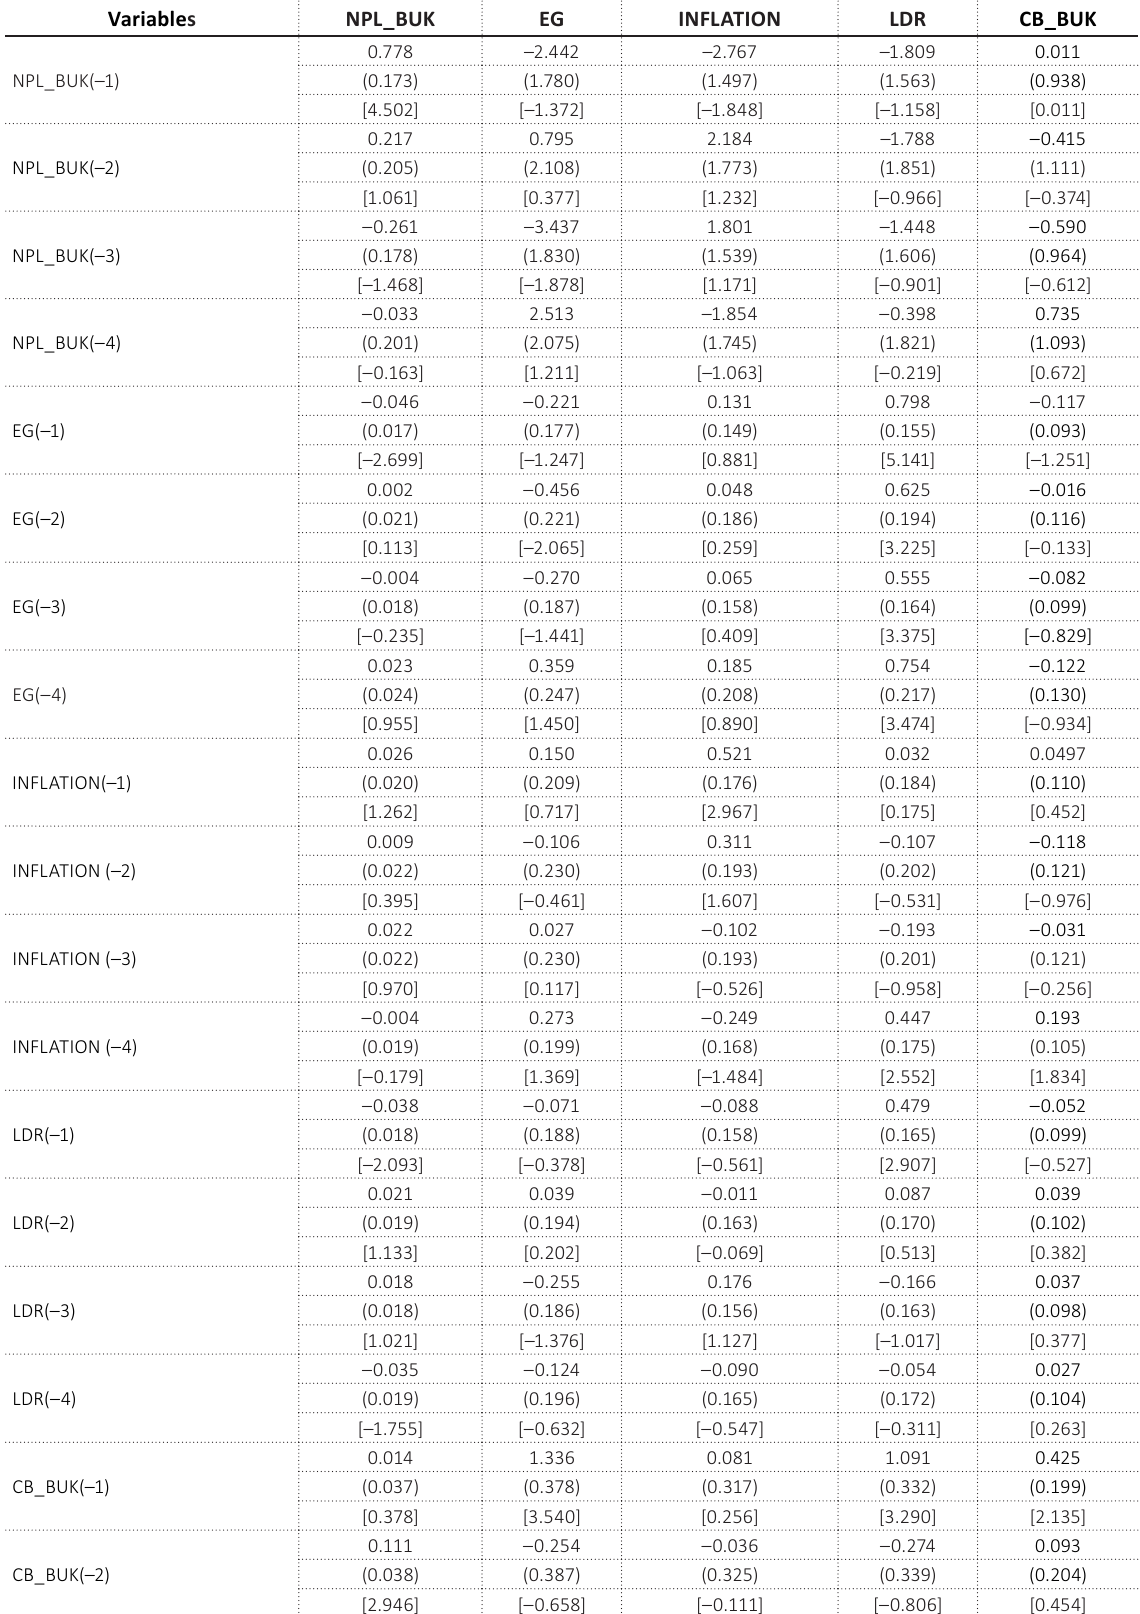
Table A6. VAR estimation result